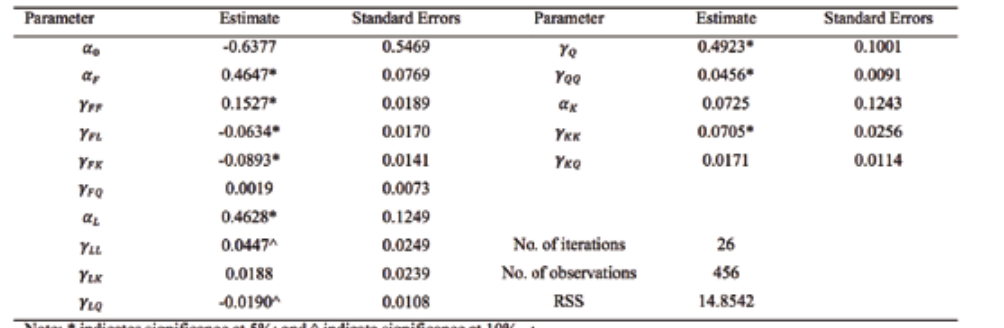
Table 3: Results of Translog Cost